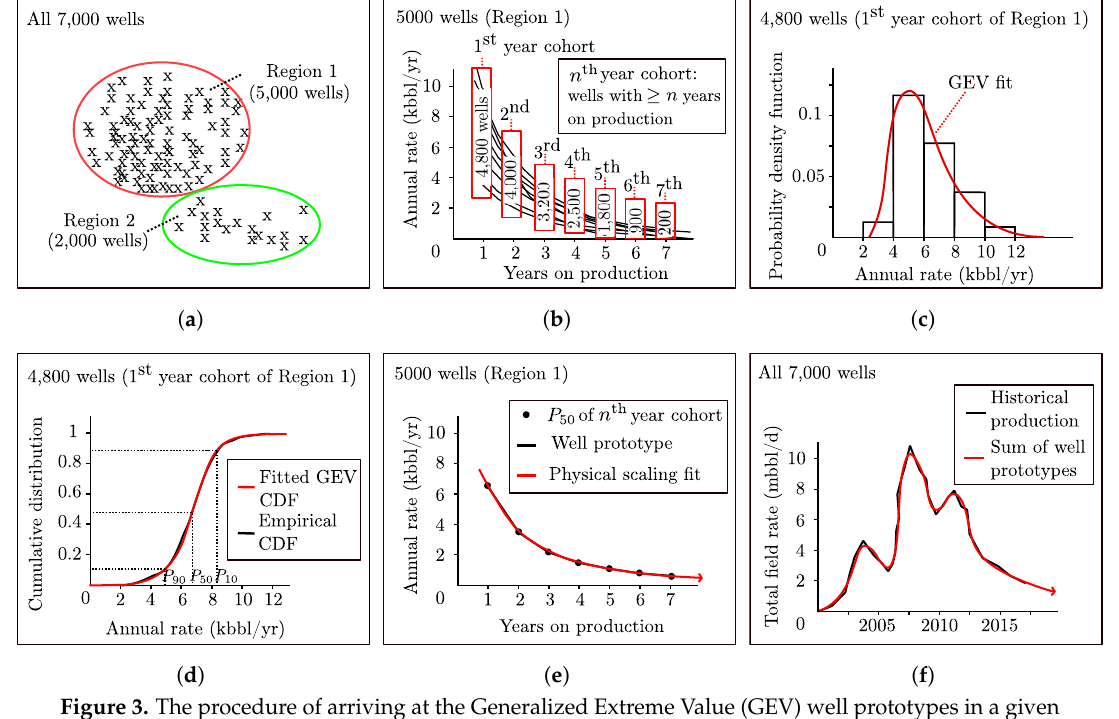
Figure 3. The procedure of arriving at the Generalized Extreme Value (GEV) well prototypes in a given shale play. ( a ) Define static regions in which oil production is statistically uniform. ( b ) For each region, gather the dynamic cohorts of wells with ≥ i years on production, i = 1,2,3, . . . . ( c ) Fit GEV probability density function (PDF) to each well cohort. ( d ) From the corresponding cumulative distribution function (CDF) pick the P 10 , P 50 , and P 90 values for each cohort. ( e ) Construct time-lapse P 50 well prototype for each region, by connecting all P 50 values of all cohorts. ( f ) Time-shift and superpose the GEV well prototypes to match past production. Reproduced from our previous work